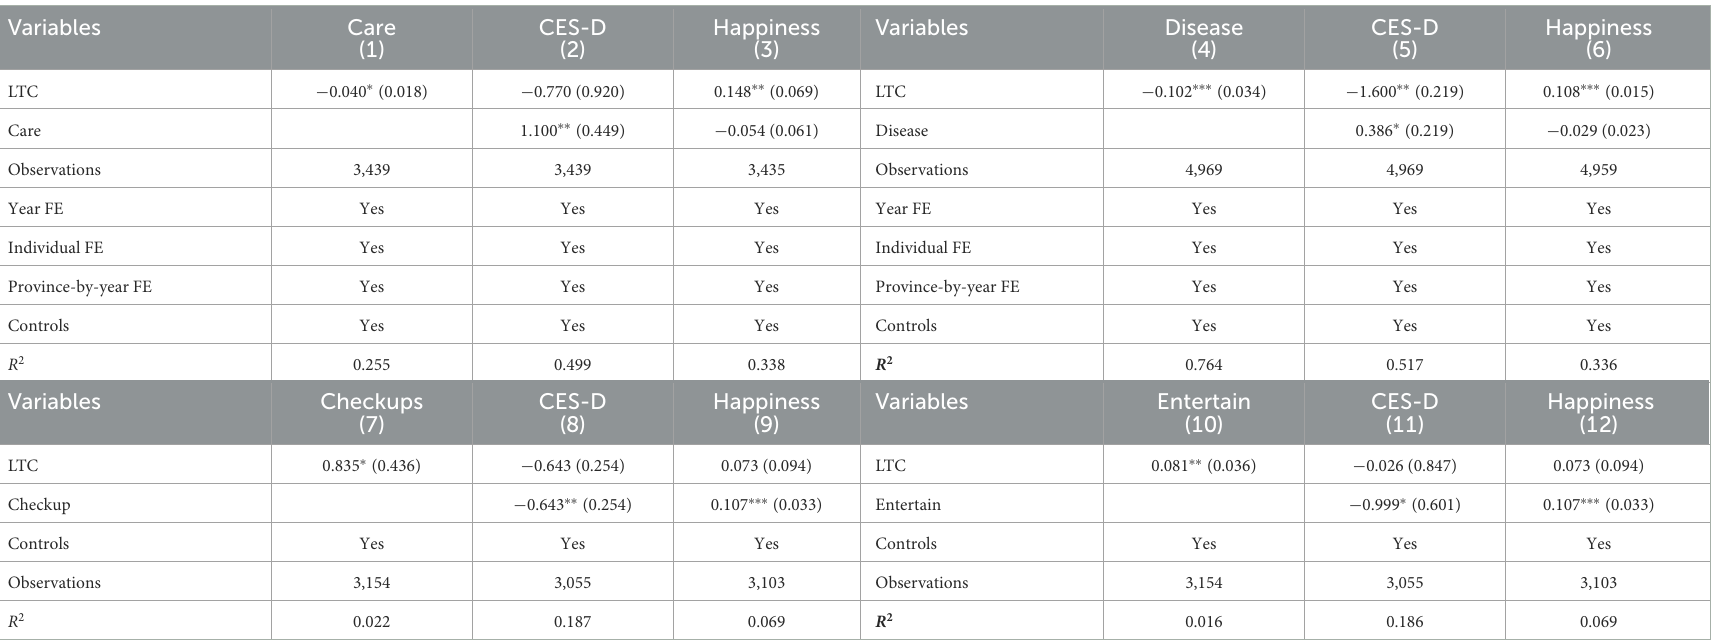
TABLE 10 The results of mediating